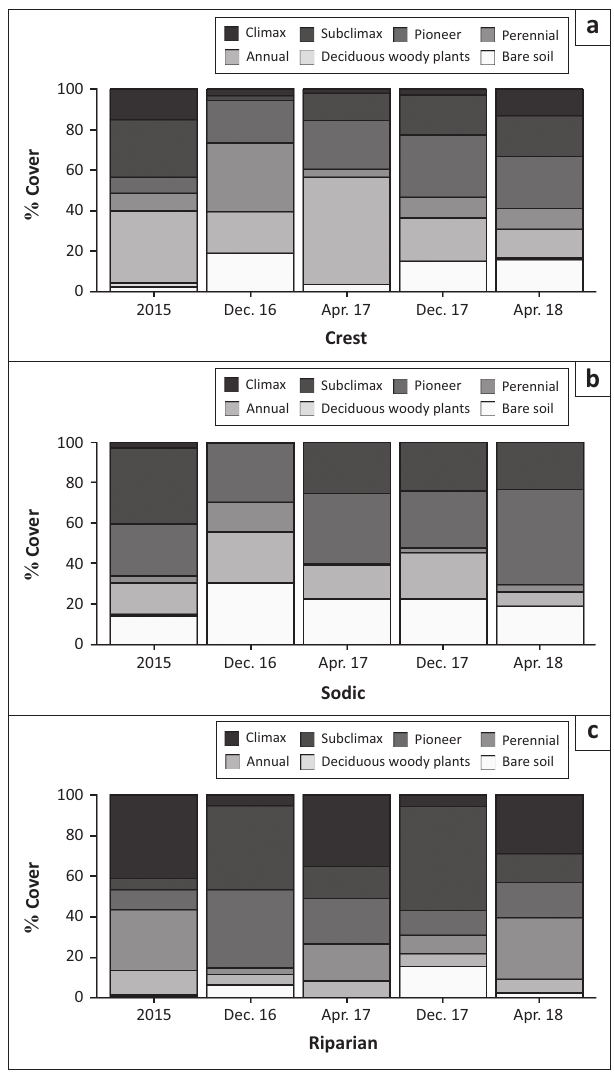
FIGURE 4: Graphs showing the different percentage covers of different growth forms ([a] crest, [b], sodic site and [c] riparian) during the different sampling